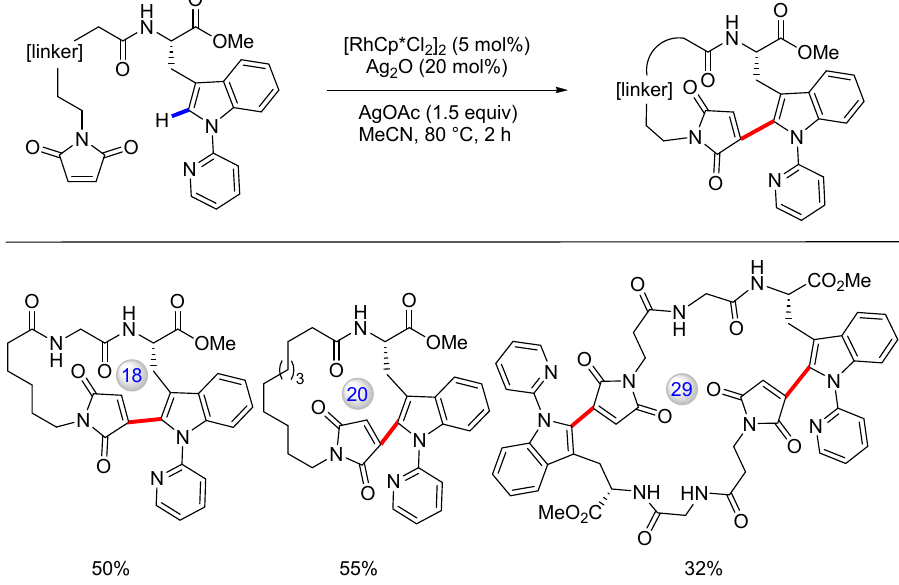
Figure 9. Synthesis of maleimide-decorated peptide macrocycles via the Cp*Rh(III)-catalyzed intramolecular C(sp 2 ) − H alkenylation of tryptophan [67].